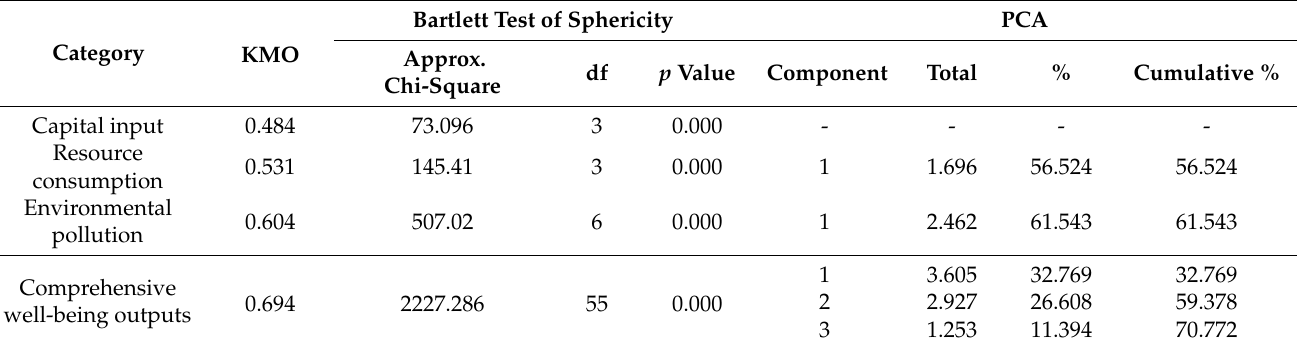
Table 3. KMO, Bartlett’s test, and